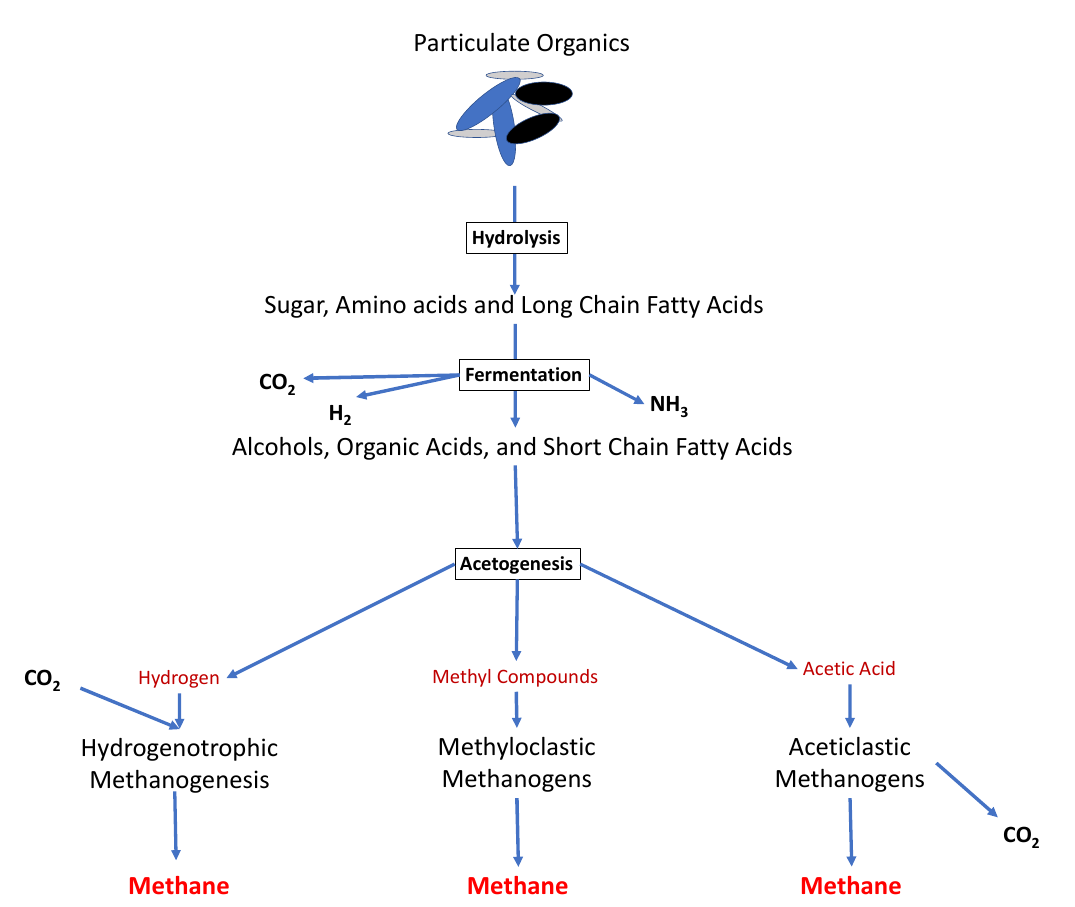
Figure 1. The overall metabolic pathways of anaerobic digestion. Polymeric organic materials go through the four stages of anaerobic digestion (hydrolysis, acidogenesis, acetogenesis and methanogenesis), in order to produce raw biogas.